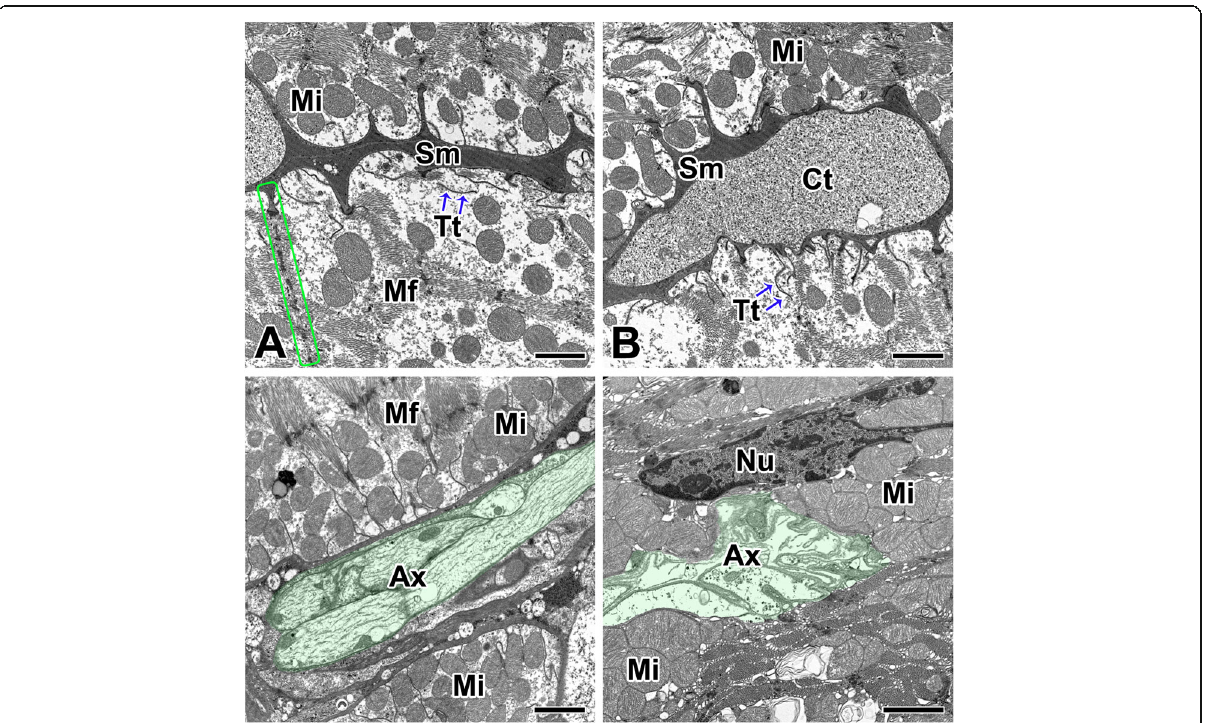
Fig. 4 Transmission electron micrographs of the cardiac muscle cell and its neural innervation in the spider L. mactans. a , b : Sarcolemma (Sm) is connected with the basement membrane which surrounds connective tissues (Ct), or to other muscle cells creating a very strong fiber. c , d : Cardiac muscle fiber is innervated by neural bundles containing axons (Ax) from neurons of the cardiac ganglion. d : Neuronal axons are connected to the individual muscle fibers at the neuromuscular junction. Mf: myofbril, Mi: mitochondria, Nu: nucleus, Tt: T-tubules. All scale bar indicates 2 μ